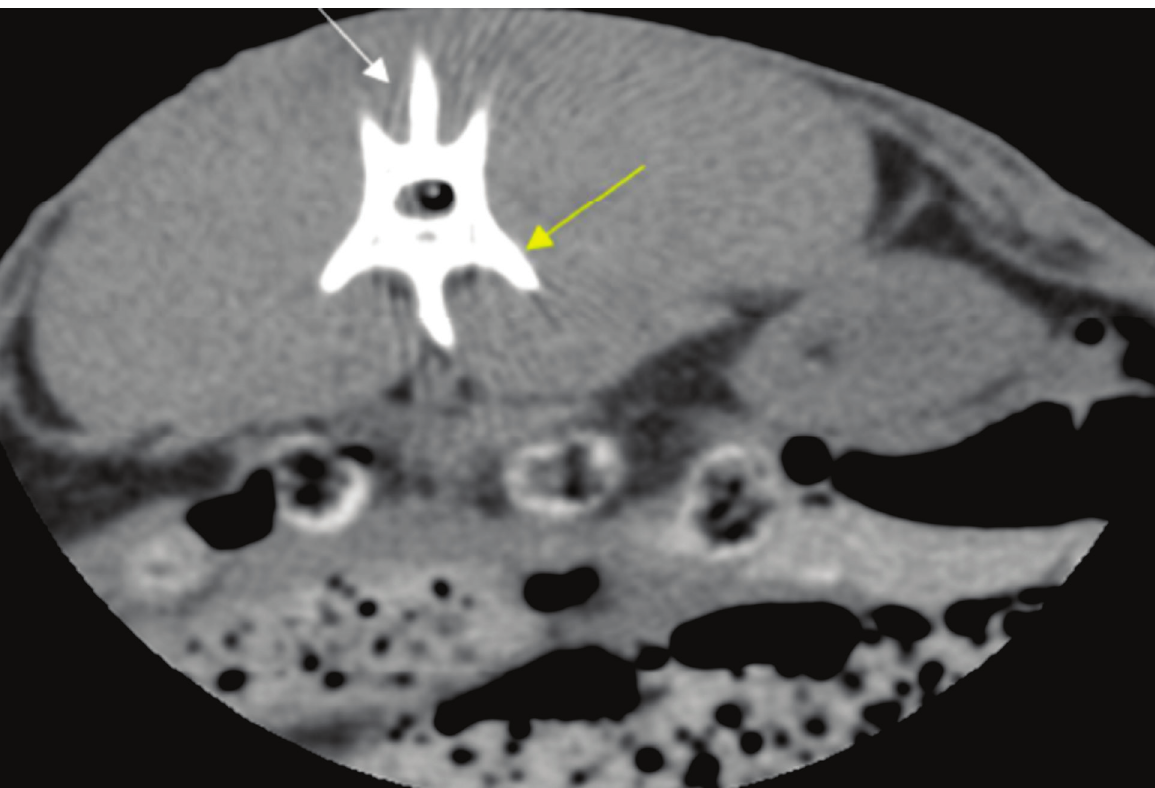
Figure 3 - Tomographic image showing the catheter’s placement. Thoracic vertebra T13, spinal process (white arrow), transverse process (yellow arrow). Source: personal archive,